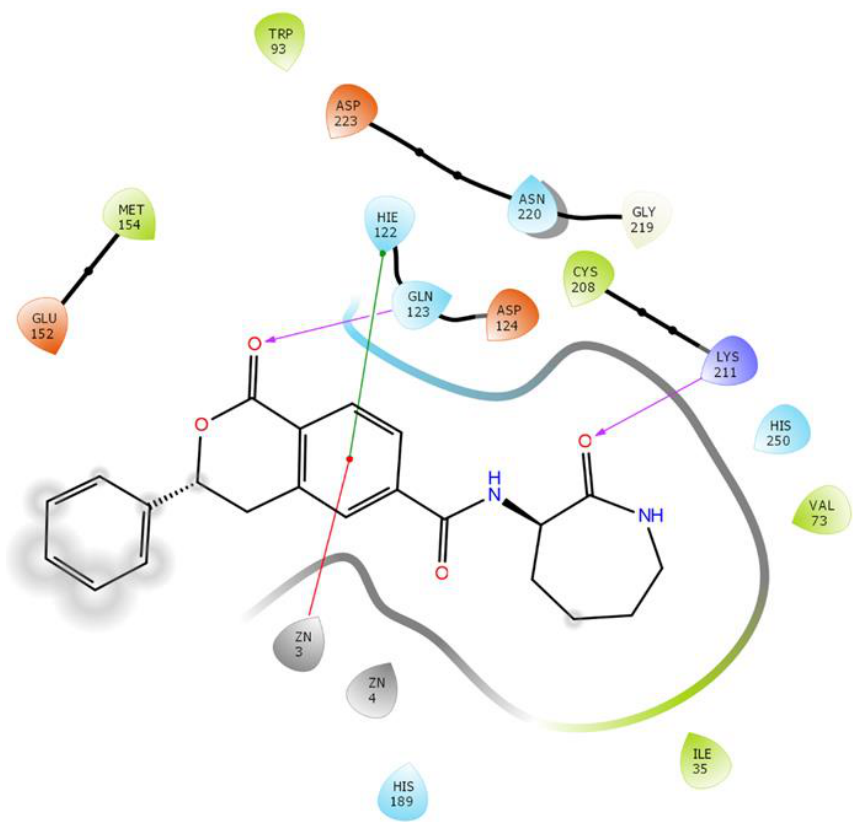
Figure 5. The interaction between ZINC84525623 and NDM-1 after molecular dynamic (MD) simulation. ZN3 and ZN4 correspond to Zn1 and Zn2 of the X-ray crystal structure. Hydrogen bonds, hydrophobic interaction, and electrostatic interaction are shown in pink, green, and red, respectively. Residues shown in red, green, blue, and purple are charged, hydrophobic, and polar residues, respectively. Glycine and metal ions are shown in white and black, respectively.